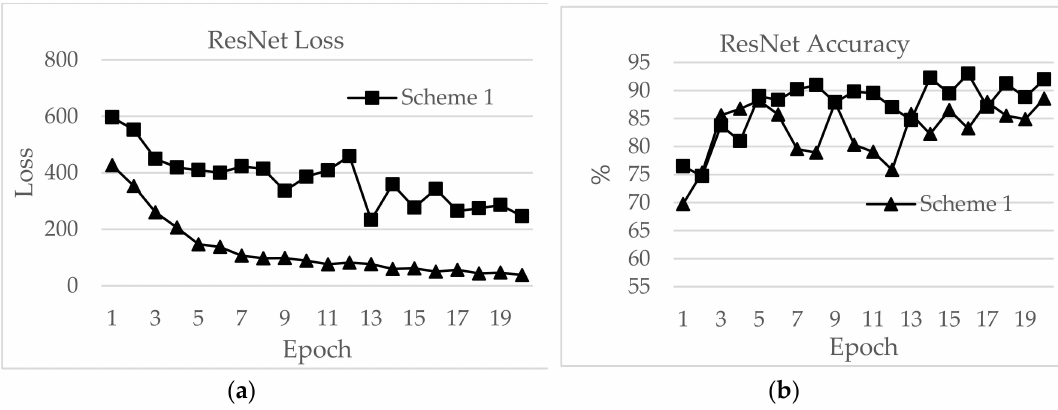
Figure 18. ResNet ( a ) loss curves and ( b ) accuracy